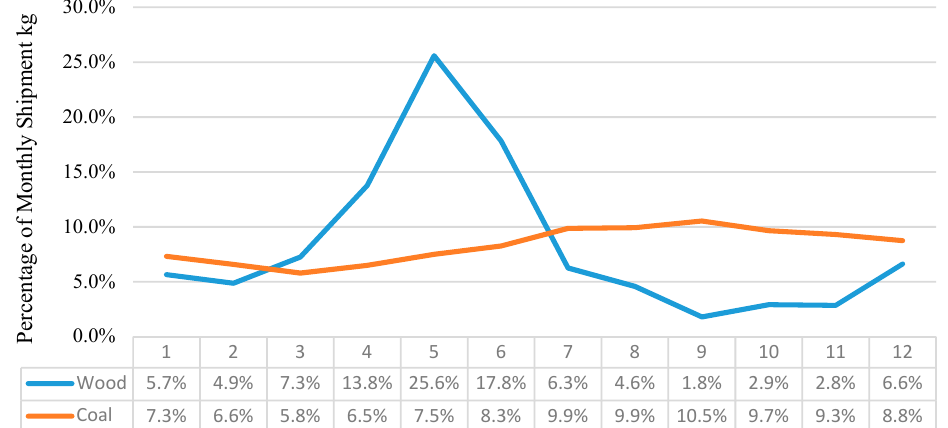
Figure 5. Monthly Variations of feedstock supply in study area.